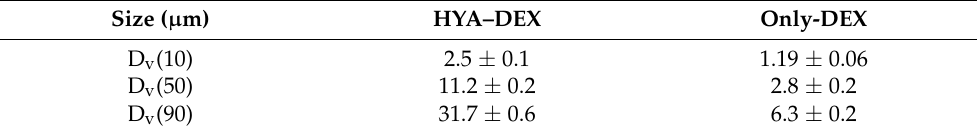
Table 1. Volume-weighted diameters ( µ m) at 10th, 50th and 90th percentiles obtained from the cumulative curve of spray-dried powder of DEX alone or with